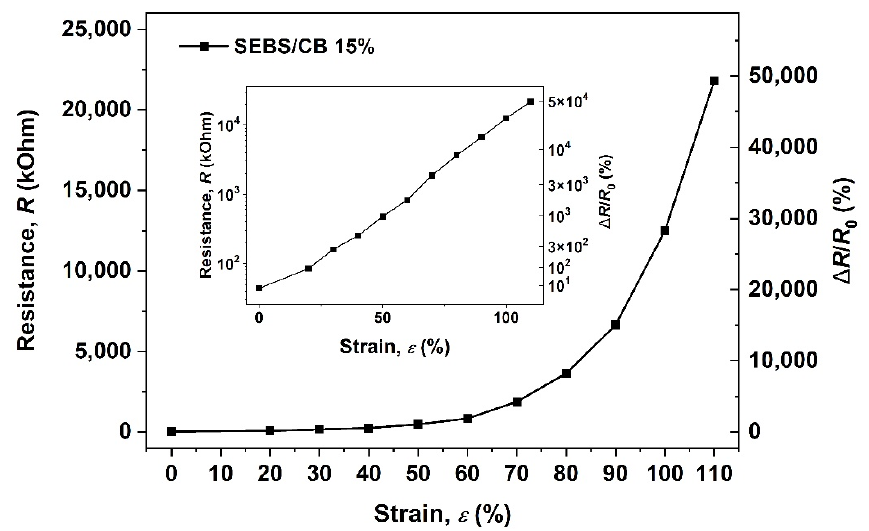
Figure 4. Electromechanical behaviour of styrene-b-(ethylene-co-butylenes)-b-styrene triblock co- polymer, filled by 15 wt.% of carbon black (CB).